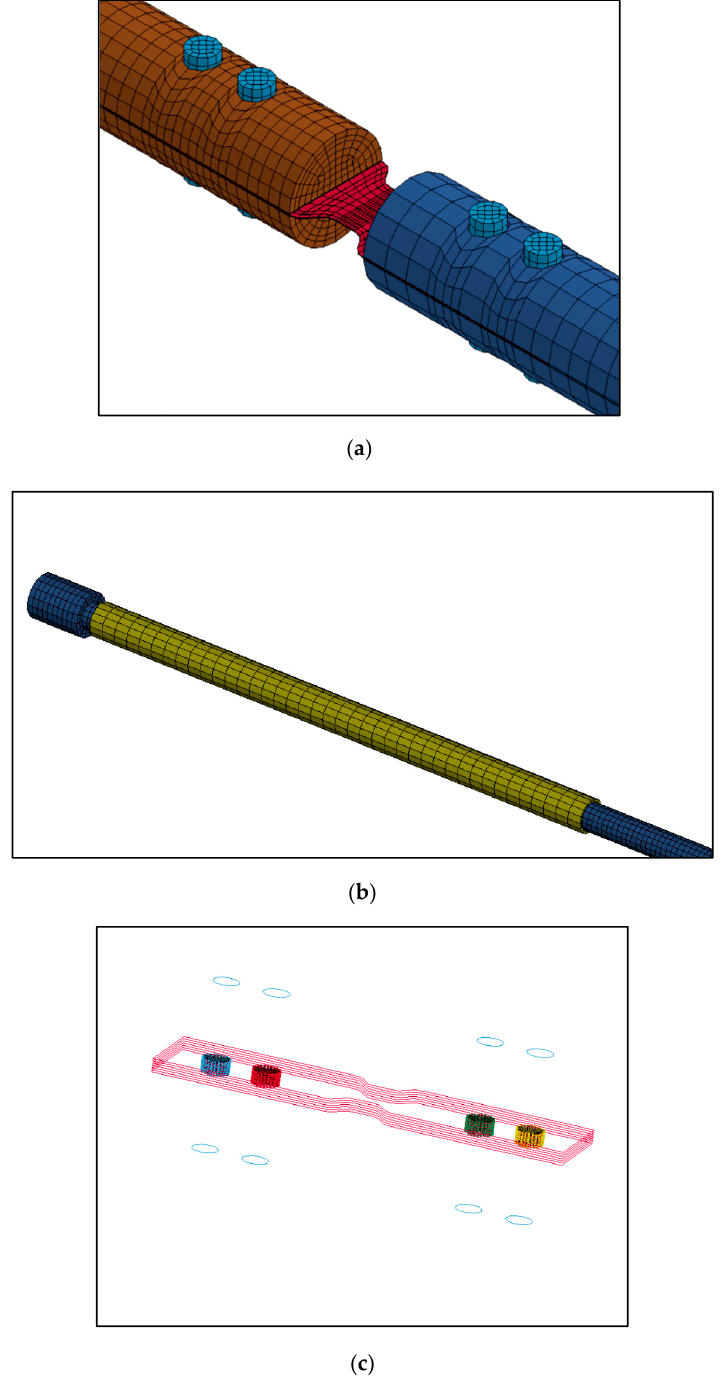
Figure 7. ( a ) Close-up view of the connection between the bars, the bolt, and the specimens. ( b ) Close-up view of the impactor and the momentum trap. ( c ) Constant nodal rigid body connection of the specimens to the bolts. Two parameters are simulated for the SHTB simulation: the effect of stacking and the effect of loading velocity. For the simulation of the stacking effect, the specimens are stacked on top of each other to amplify the transmitted signal. The number of stacked layers is varied at one, three, five, and seven stacks. The result of the stacking simulation was compared with the simulation using a single- layer specimen with a total thickness equivalent to the stacked specimens to check whether the stacking method might give a different strain reading or deviation from the single-layer specimen result. Stress variation due to the application of stacking is also observed to check whether the amount of stacking could alter the stress–strain result or not. Figure 3 shows a model with stacked layers of specimens and the corresponding single-layer specimen with equivalent thickness. Table 2. Dimension of each SHTB component with the corresponding simulated material. Component